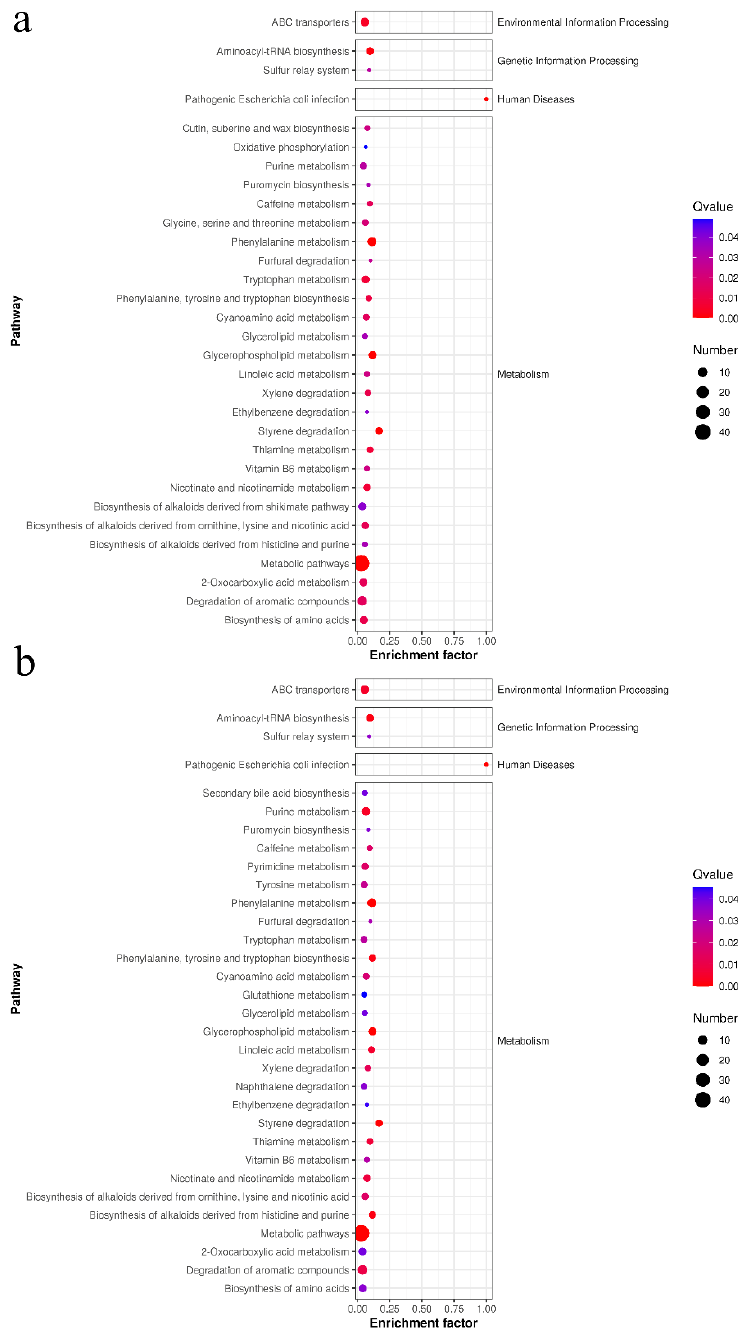
Figure 9. Bubble diagram of the different metabolic pathways in the aqueous extraction group ( a ) and the alcohol extraction group ( b ). and the alcohol extraction group ( b